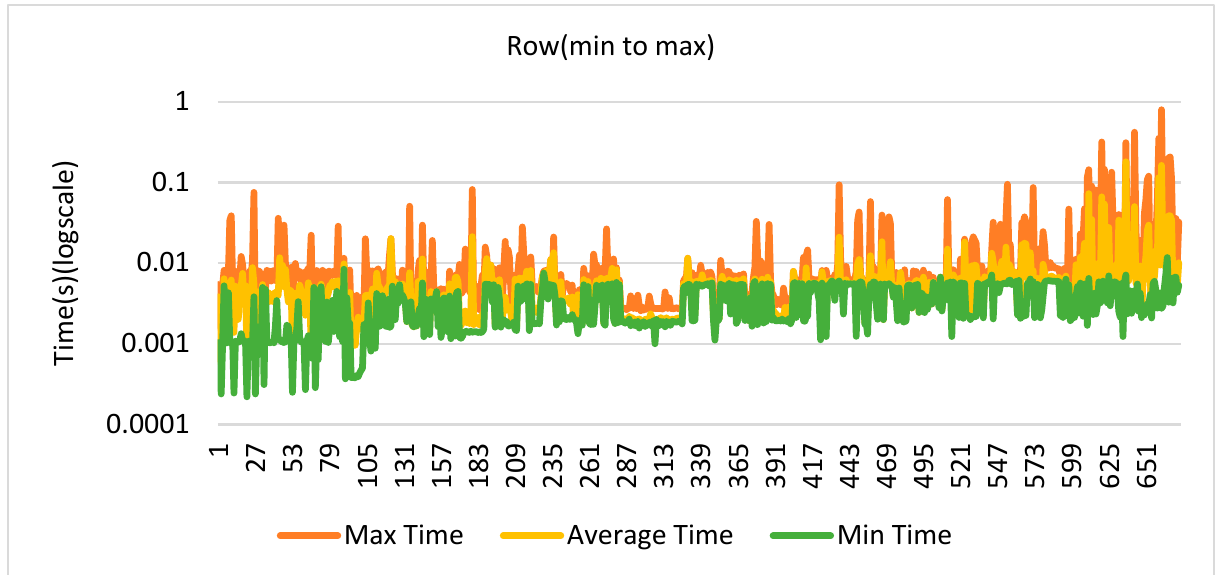
Figure 5. Execution time comparison of SpMV computation (dataset sorted by row-min to max). The pre-processing or format conversion cost is highlighted in Figure 6, which shows execution time comparison with and without including the conversion time of CSR to BCSR format. The X-axis shows matrices in our dataset sorted on number of rows from minimum to maximum. Depending on the structure, CSR performs well for some matrices but overall BSCR (including conversion cost) shows better performance against matrices, included in our